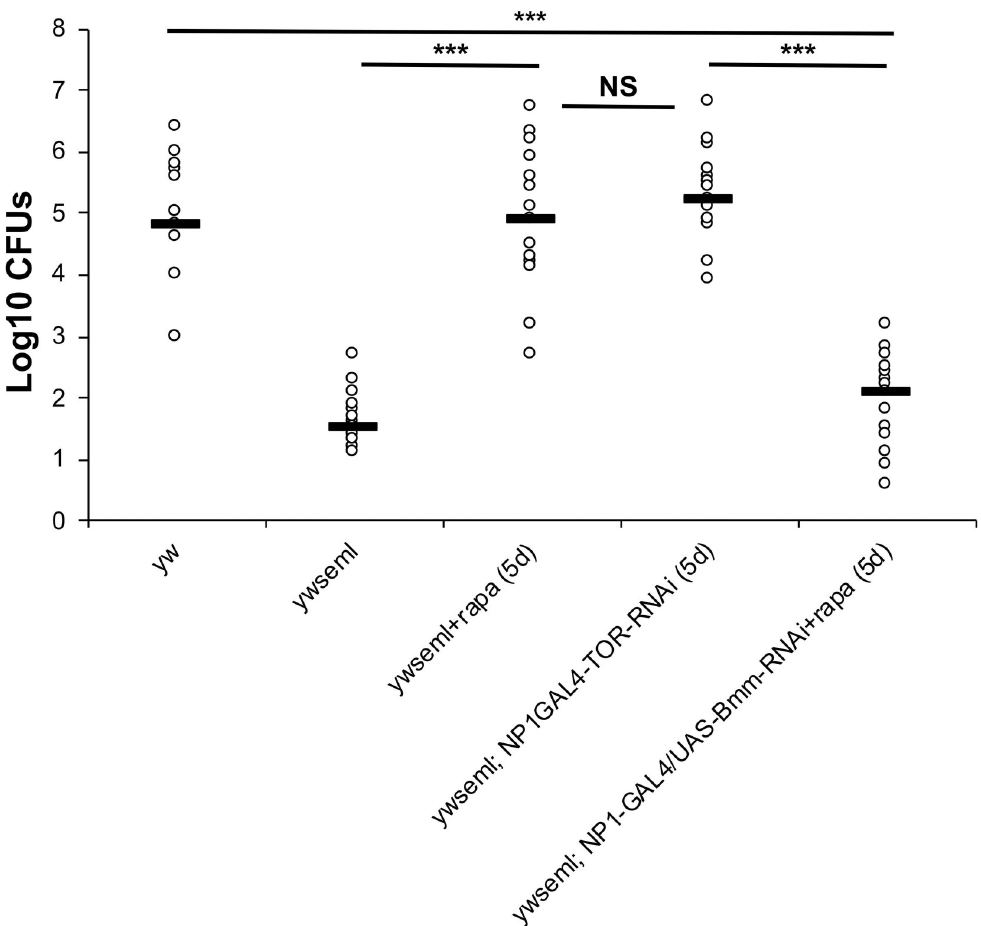
Fig 7. Reduction of bacterial density is connected to gut lipid catabolism. Rapamycin treatment or TOR-RNAi in ECs of ywseml flies restored intestinal bacterial CFUs at the levels of the genetic background of the levels of the genetic background of yw . However, this was not the case when the lipase bmm was knocked down in ECs. N = 15/genotype/ treatment a total of three independent experiments (each with n = 5/genotype/treatment). Values of mutants and controls were statistically compared using student’s t-test ( ��� p < 0.001, NS is